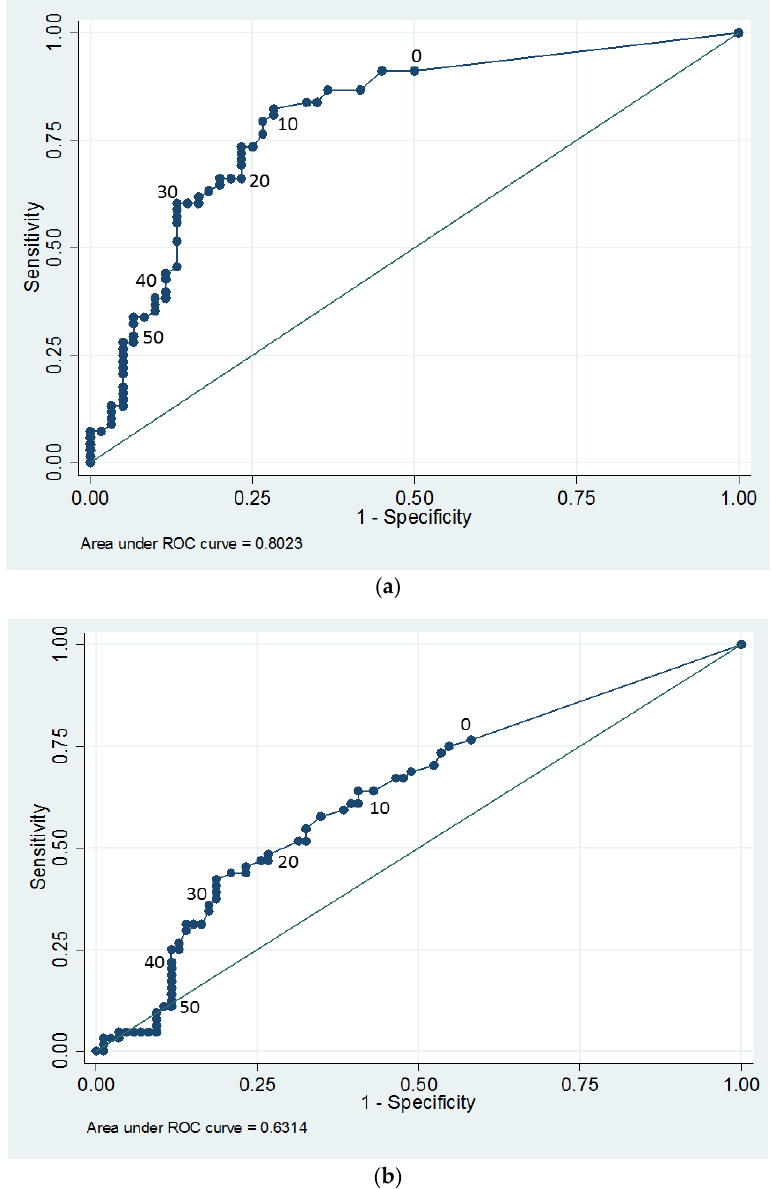
Figure C1. Receiver Operator Characteristics (ROC) Curve for relationship between extent of scarring and dog aggression ( a ) among males; ( b ) among females. A threshold of 10 or more scars was chosen for further analysis, for logistical and statistical reasons (see text). Numbers represent total number of scars in the 3 body zones: front legs, dorsum of head and lateral face, and muzzle and oral mucosa.